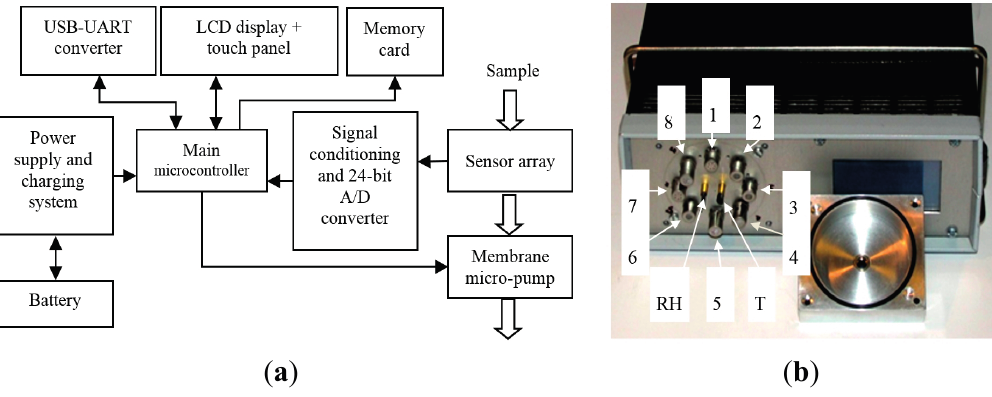
Figure 1. ( a ) Construction of the e-nose and laboratory setup: block diagram of